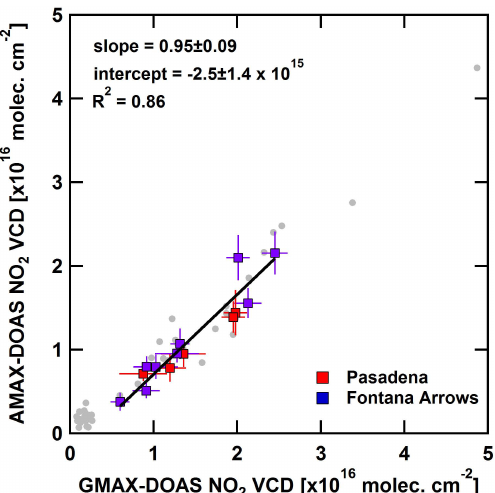
Fig. 9. Correlation plot of modeled and measured O 4 SCDs at 477nm for the case study shown in Fig. 10b. SCD of the zenith reference (9 × 10 42 molecules 2 cm − 5 ) has been added to the mea- sured O 4 dSCDs. Forward viewing geometry includes 0 ◦ , ± 2 ◦ , ± 5 ◦